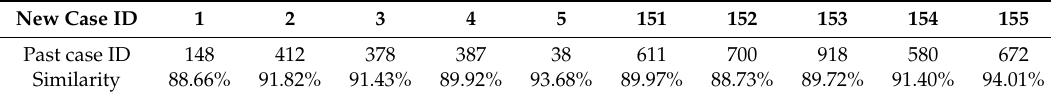
Table 3. Some retrieved similar past cases and their corresponding similarity